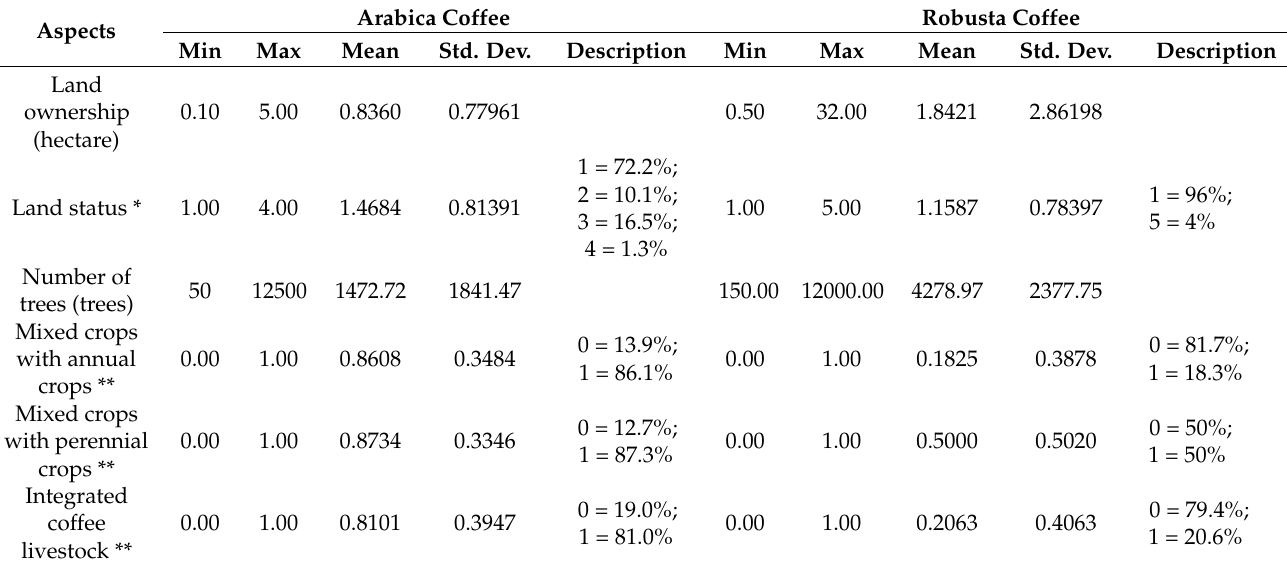
Table 2. Farming system characteristics of